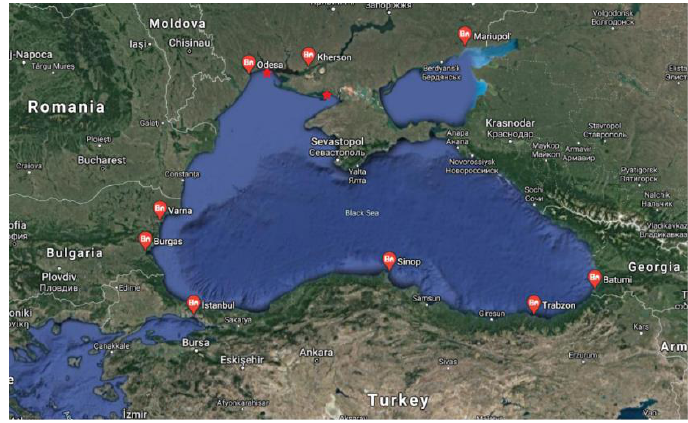
Figure 2. Locations of the meteorological stations used in the study [16]. The two stars indicate the positions of two towns, Ochakiv and Khorli, mentioned further on in the text. Table 1. Summarized data used in the